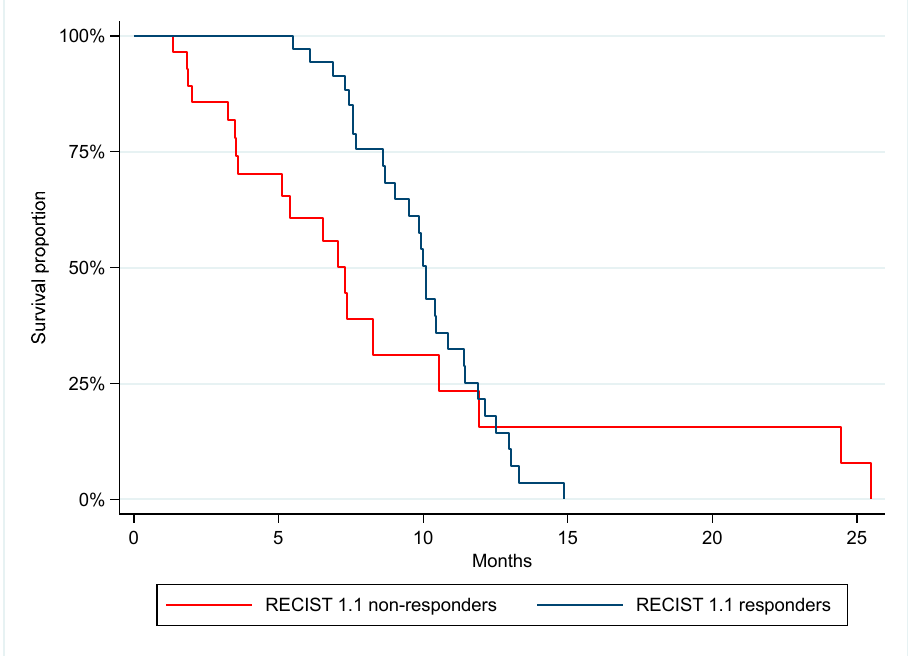
Figure 3. Progression-free survival according to RECIST 1.1 response. Median PFS was 10.1 vs. 7.3 months, p = 0.17, HR = 0.65.